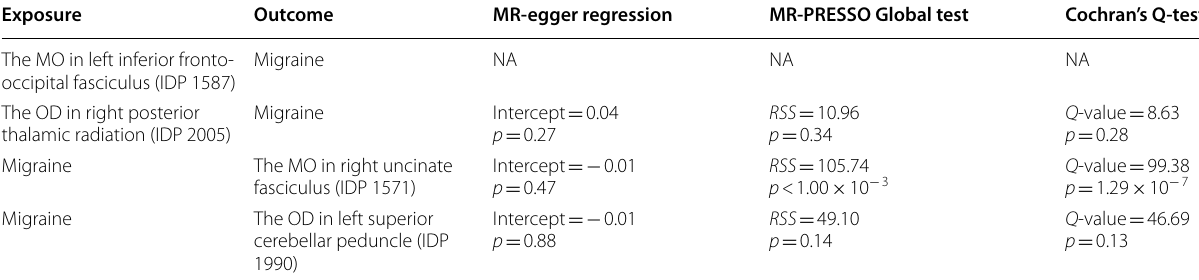
Table 1 The results of sensitivity analysis